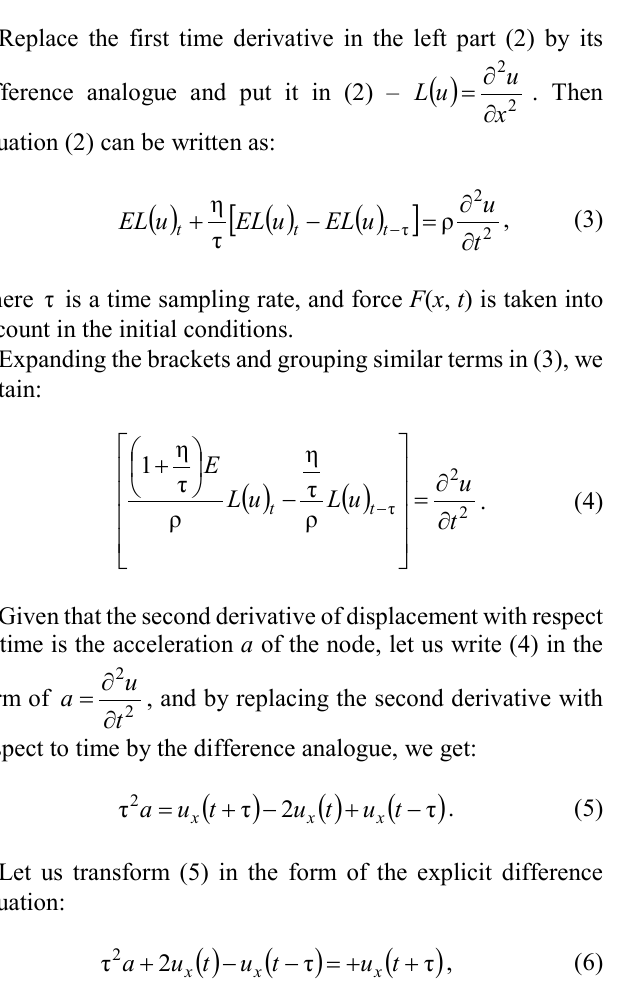
Fig. 2. Discrete model for the rod.